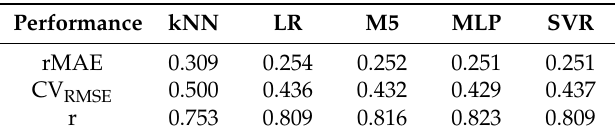
Table 4. Average performance measures of relative error terms (rMAE and CV RMSE ) and correlation for 1–6 h